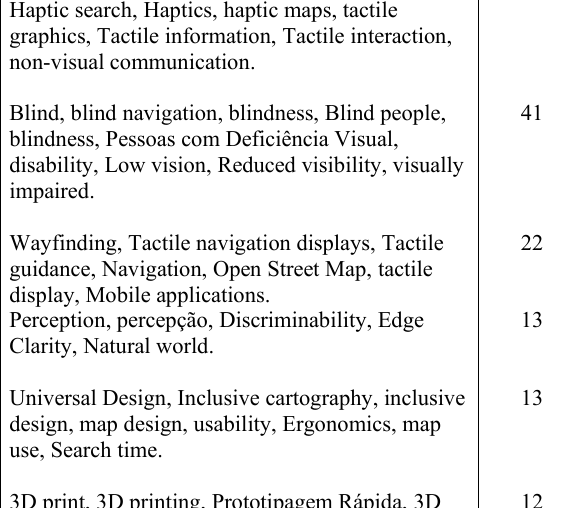
Mapa Tátil, maps for blind, Tactile Guide Map, Tactile map, Tactile maps, handdrawn map, mapping tactile, tactile production methods, Haptic search, Haptics, haptic maps, tactile graphics, Tactile information, Tactile interaction, non-visual communication. Blind, blind navigation, blindness, Blind people, blindness, Pessoas com Deficiência Visual, disability, Low vision, Reduced visibility, visually impaired.